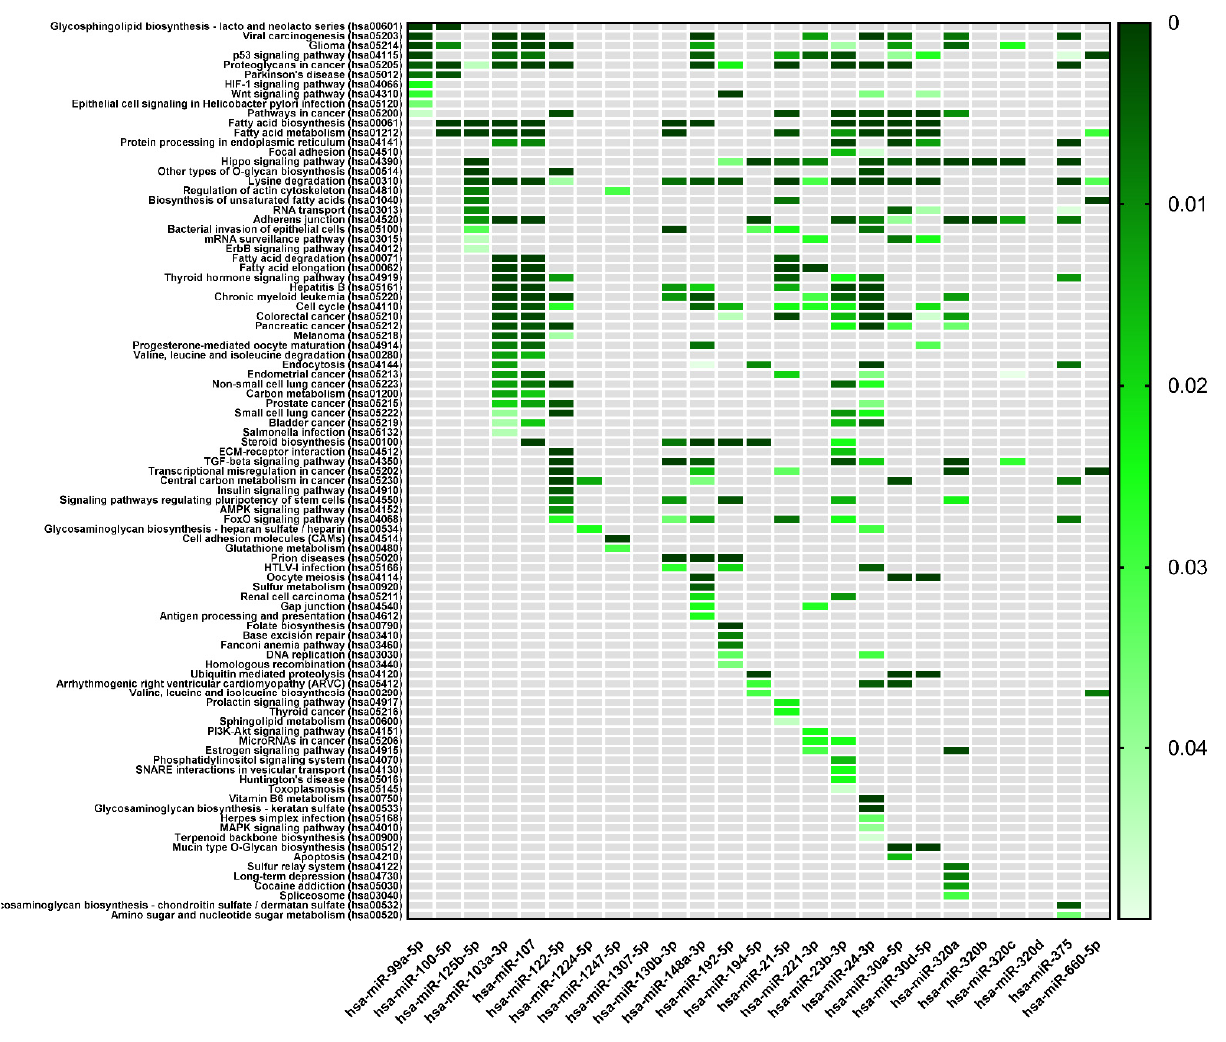
Figure 5. Heatmap of significant pathways predicted by DIANA-miRPath (v.3.0) for twenty-seven differentially expressed miRNAs in serum of ALF patients. KEGG pathways classification analysis of differentially expressed miRNAs is presented on the y-axis and miRNAs on the x-axis. The color intensity represents the p-value with dark green as the most significant predicted miRNA-pathway interactions ( p < 0.05 in Fisher’s Exact